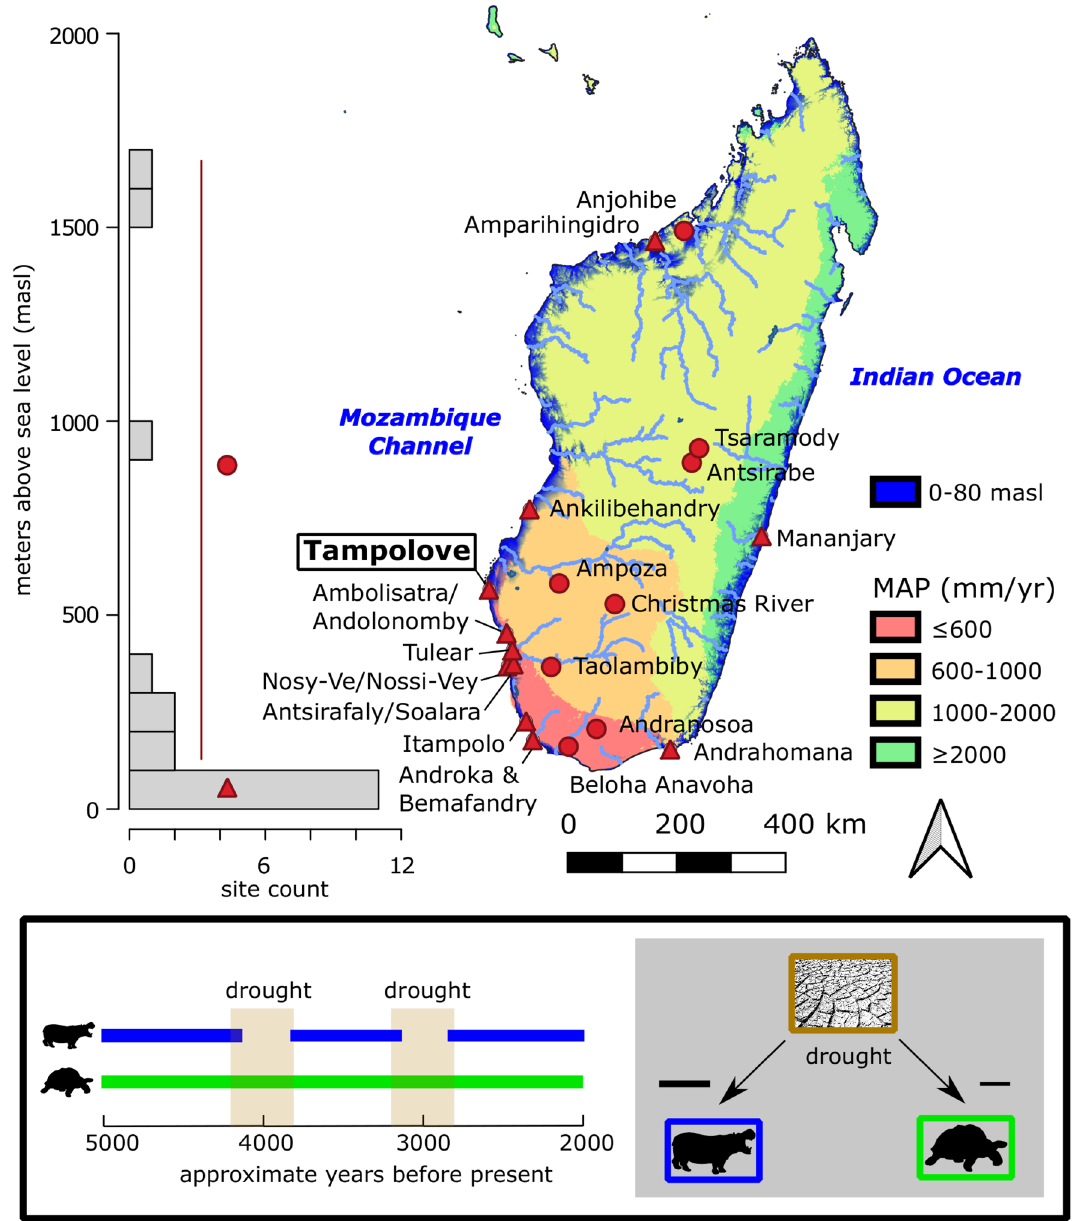
Figure 1. Geographic context of study area (Tampolove), and concept of drought tolerance based on past occurrence data. Points mark the sites that include 14 C dated collagen from extinct pygmy hippos ( Hippopotamus spp.) and giant tortoises ( Aldabrachelys spp.). Most sites are in the coastal lowlands (triangles), where changes in both climate and relative sea level can contribute to drought. At arid coastal sites, we would expect a relatively drought sensitive animal (e.g., hippos) to be extirpated during past drought as ranges contract up comparably wet inland drainages. Note that rainfall data reported as mean annual precipitation are taken from WorldClim 2.1 35 and that map was generated in QGIS (version 3.10.2, www. qgis.